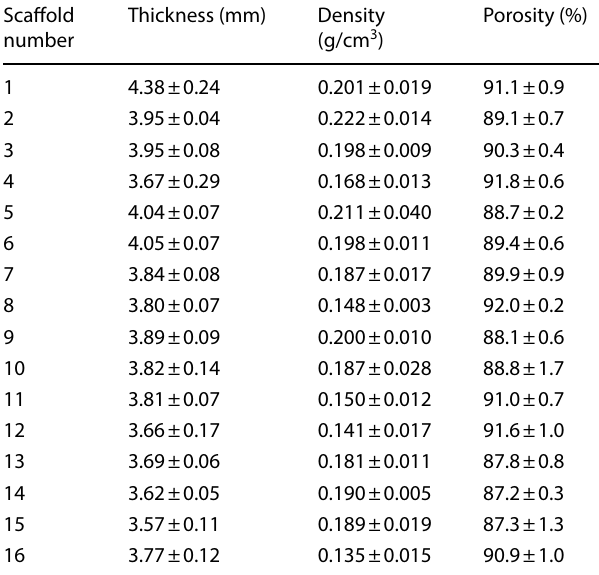
Table 2 The thickness, density, and porosity of the scaffolds listed in Table 1 Scaffold